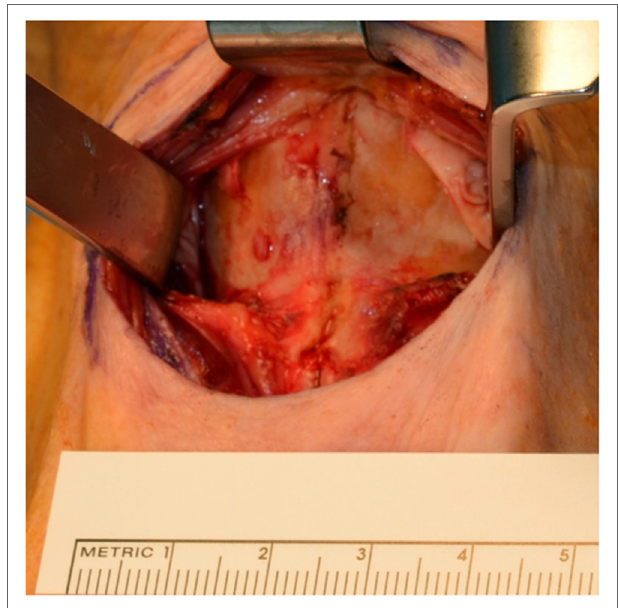
FigUre 2 | Dissection of anterior aspect of thyroid and cricoid cartilages.